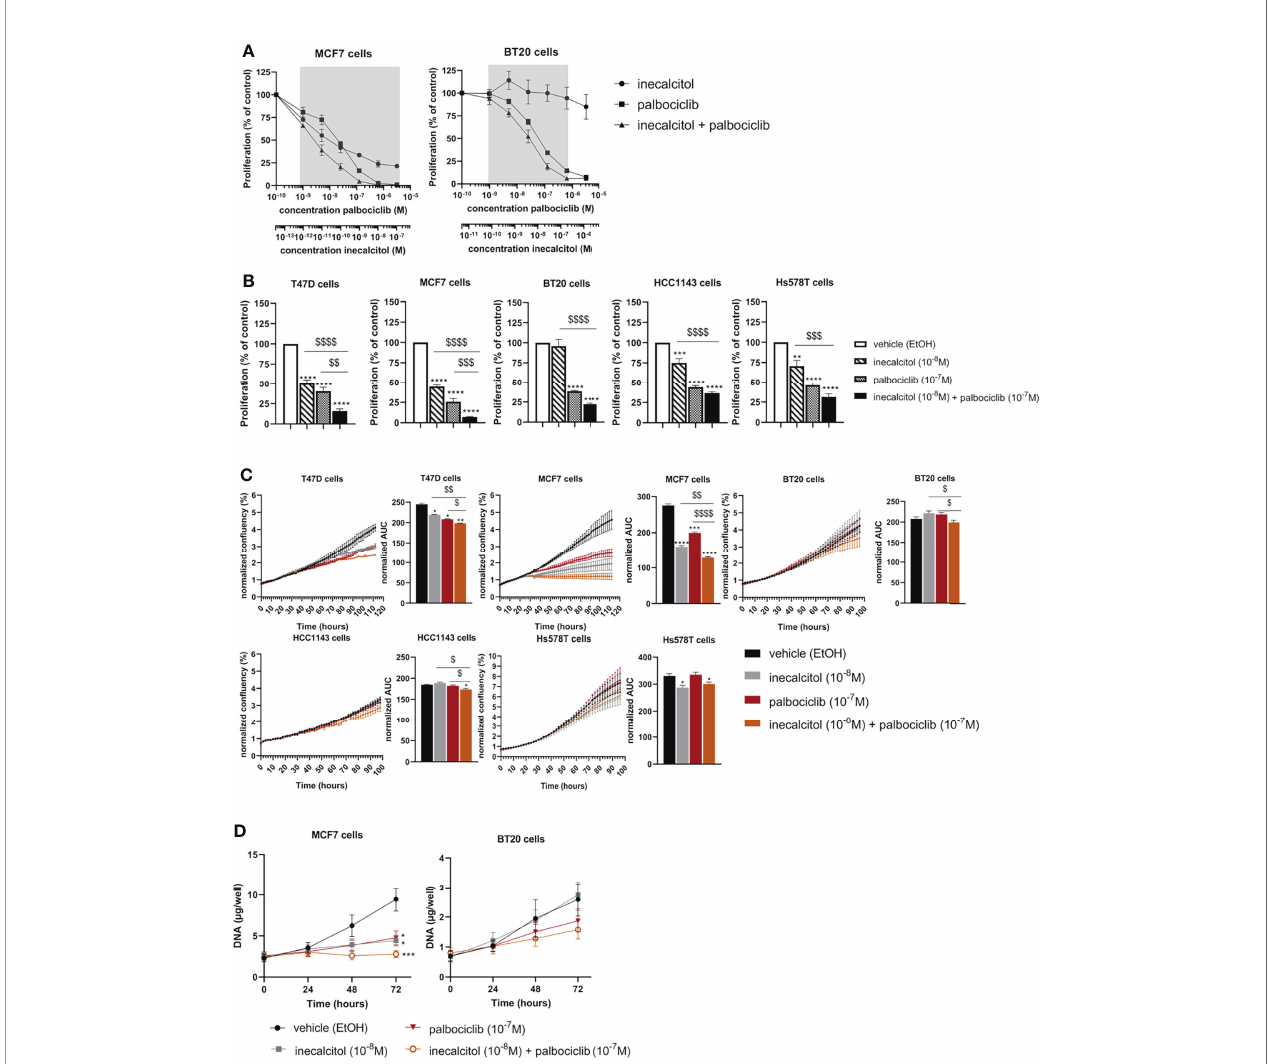
FIGURE 2 | Effect of inecalcitol and/or palbociclib treatment on BC cell growth and proliferation. (A) Dose titration analysis of inecalcitol and palbociclib alone or combined in MCF7 and BT20 cells. CI < 1; synergistic effect, in the zone indicated in grey (n=2-4 with 10 technical replicates) (B) Combined treatment of inecalcitol (10 -8 M) and palbociclib (10 -7 M) decreased cell proliferation in T47D cells (84%), MCF7 cells (93%), BT20 cells (78%), HCC1143 cells (63%), and Hs578T cells (69%) compared to vehicle treatment after 72 h (n = 4-5 with 5-10 technical replicates). Data were expressed relative to vehicle (%). (C) Cell growth was analyzed with IncuCyte live cell analysis for T47D, MCF7, BT20, HCC1143 and Hs578T cells. Well con fl uency was normalized to start density between 10-16 h. Differences between AUC were analyzed by multiple unpaired t-testing (n = 2-6 with 5 technical replicates). (D) Cell growth was assessed by DNA staining in MCF7 and BT20 cells after 24, 48 and 72 h of treatment (n = 4-5 performed in duplicate). Data shown as mean ± SEM. *p ≤ 0.05; **p ≤ 0.01; ***p ≤ 0.001; ****p ≤ 0.0001 compared to vehicle; $ p ≤ 0.05; $$ p ≤ 0.01; $$$ p ≤ 0.001; $$$$ p ≤